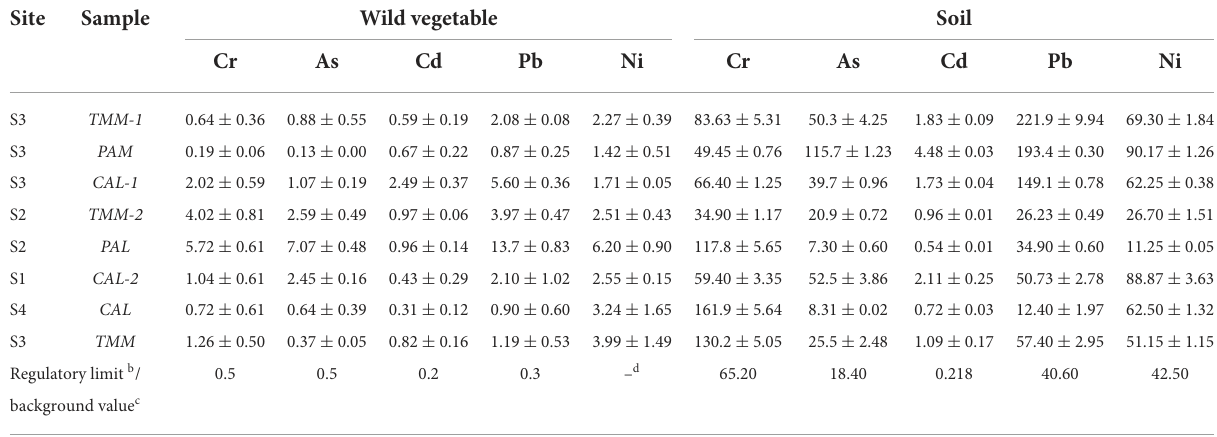
TABLE 2 Total concentrations (mg/kg) of heavy metal(loid)s a in wild vegetables and their corresponding growing soils. Site